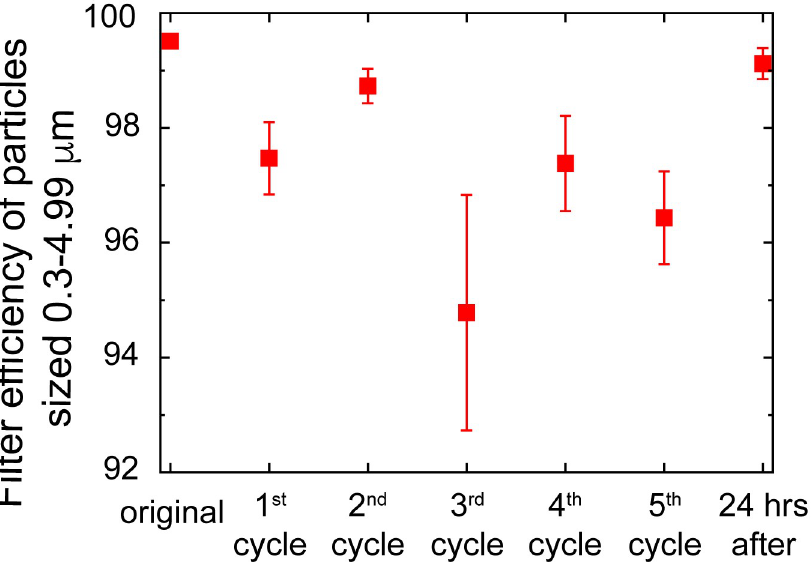
Fig 7. Filtration efficiency of particles sized 0.3–4.99 μ m at an intake rate of 2.83 L/min as outlined previously, undergoing cycles of heat treatments while placed in Ziploc